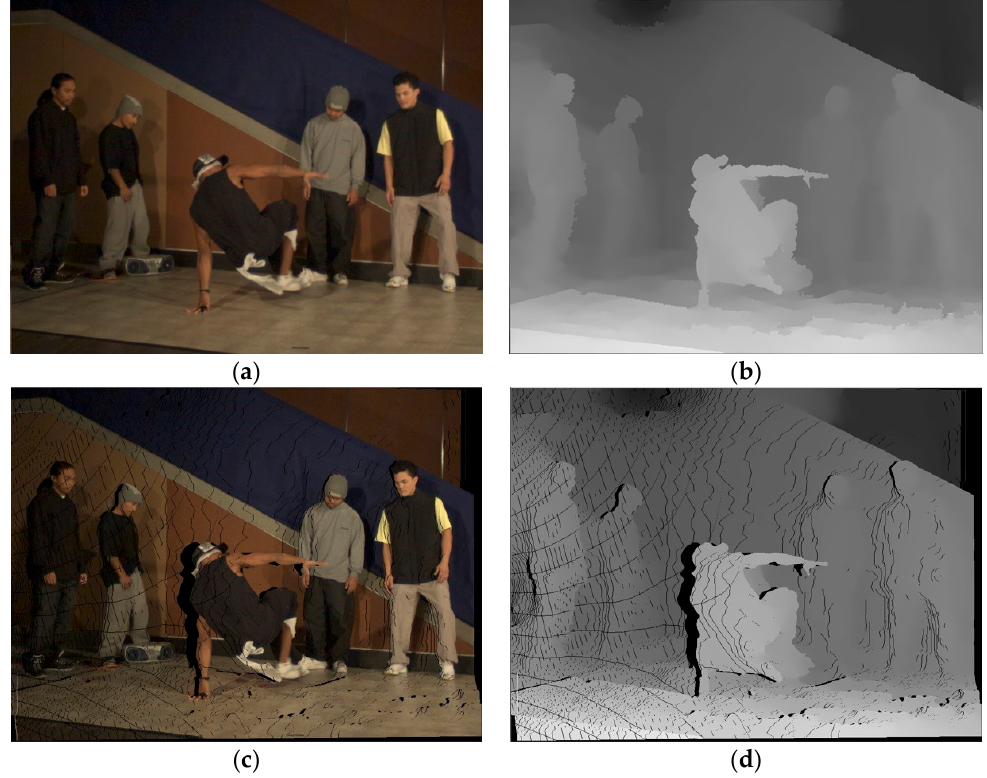
Figure 6. Example of traditional 3D warping. ( a ) Texture image, ( b ) depth map, ( c ) 3D warped texture image with erroneous points, corresponding to ( a ), and ( d ) 3D warped depth map with erroneous points, corresponding to ( b